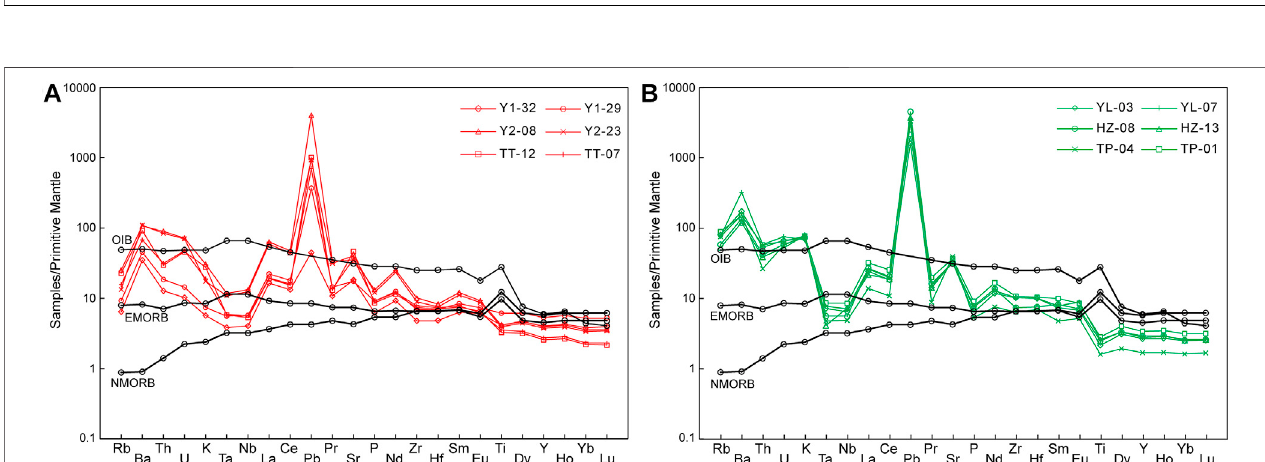
FIGURE13| Primitivemantle-normalizedspiderdiagramsfortheHuaibei-Linhuanintrusiverocksamples: (A) gabbro-dolerite; (B) (quartz-)dioriteandgranodiorite. Primitive mantle normalizing values are from Sun and McDonough (1989).